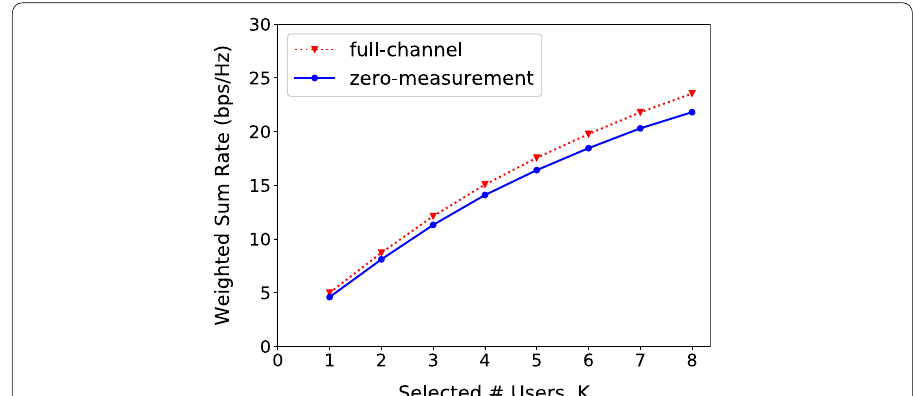
Fig. 7 The weighted sum rate with zero-measurement selection and full-channel selection, respectively. The system setup is that a 64-antenna base-station select changing number of users out of 100 users for downlink beamforming based on measured channels